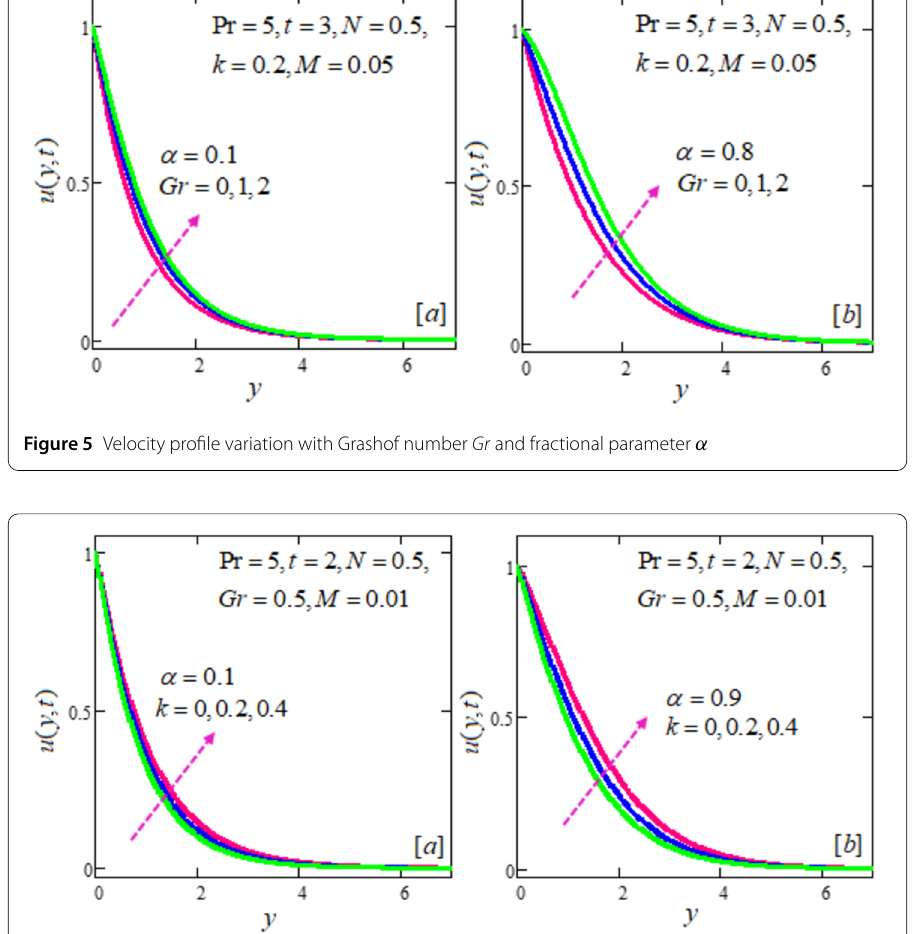
Figure 6 Velocity profile variation with porosity parameter k and fractional parameter